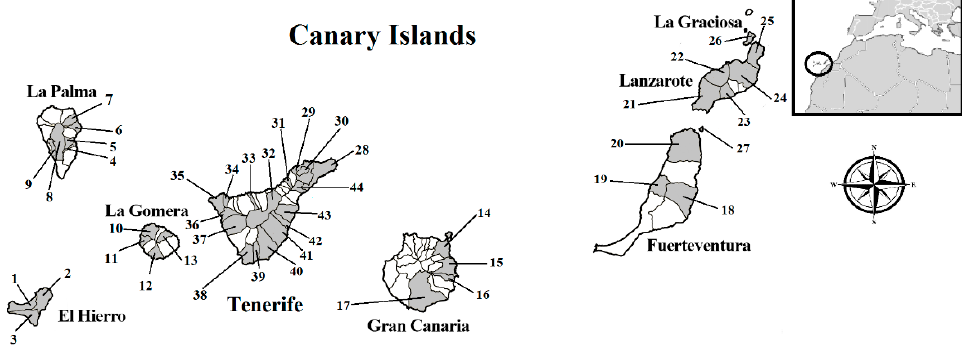
Figure 2. Map of the rodent sampling locations in the Canary Islands. The municipalities analyzed are shaded in gray. 1: Frontera, 2: Valverde, 3: El Pinar, 4: Breña Baja, 5: Breña Alta, 6: Puntallana, 7: San Andrés y Sauces, 8: El Paso, 9: Los